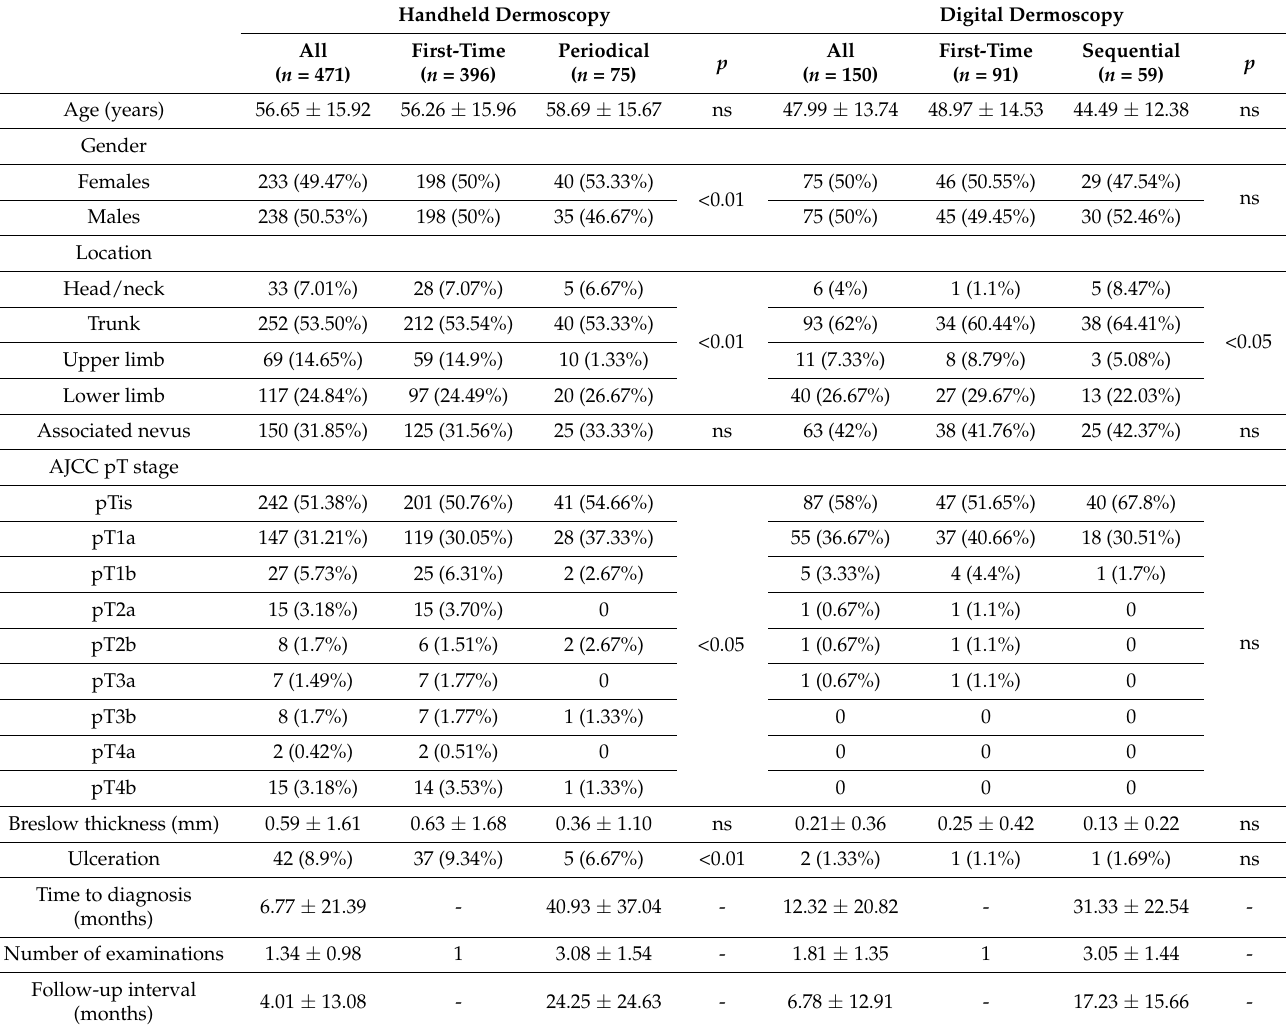
Table 1. Demographic, clinical, and histopathological data of melanomas diagnosed by handheld and digital dermoscopy. ns,